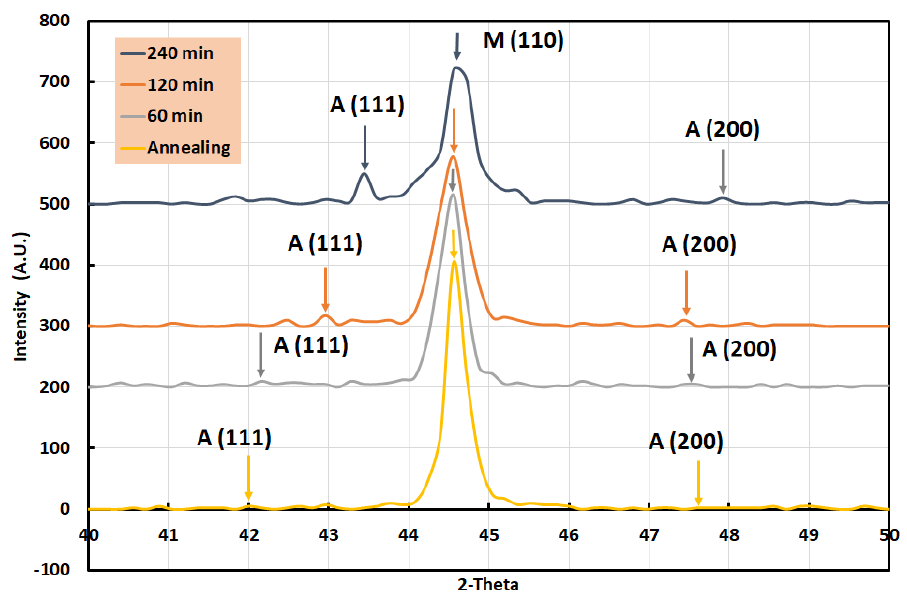
Figure 5. XRD pattern of M9.8 sample in annealing + water quenching and aging conditions at 550 °C for 60, 120, and 120 min., respectively. Table 2. Martensite % value after heat treatment.